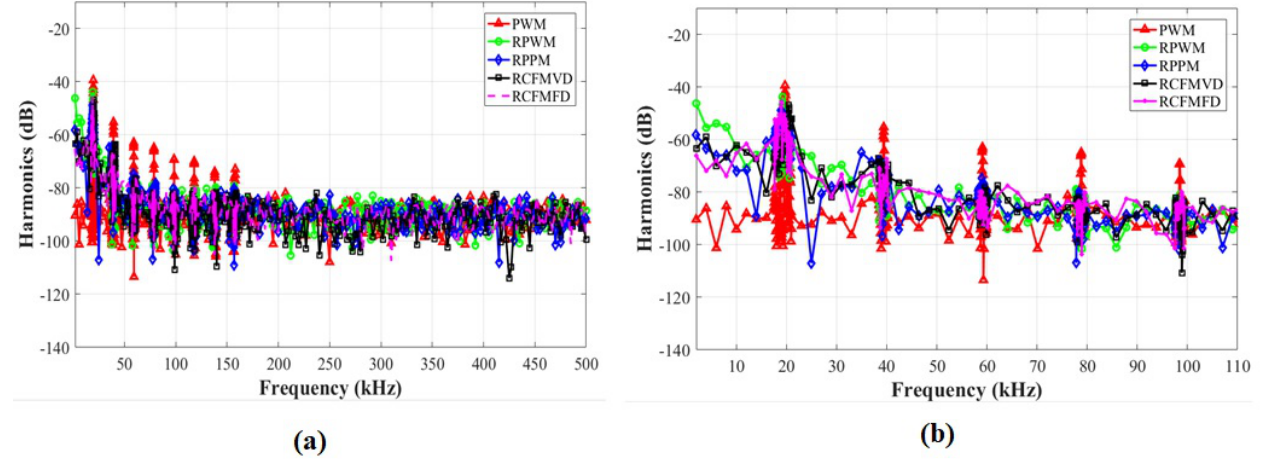
Figure 7. Comparison results for a simple buck converter for different modulation schemes: ( a ) switch- ing current harmonics and ( b ) switching current harmonics up to the fifth harmonic.